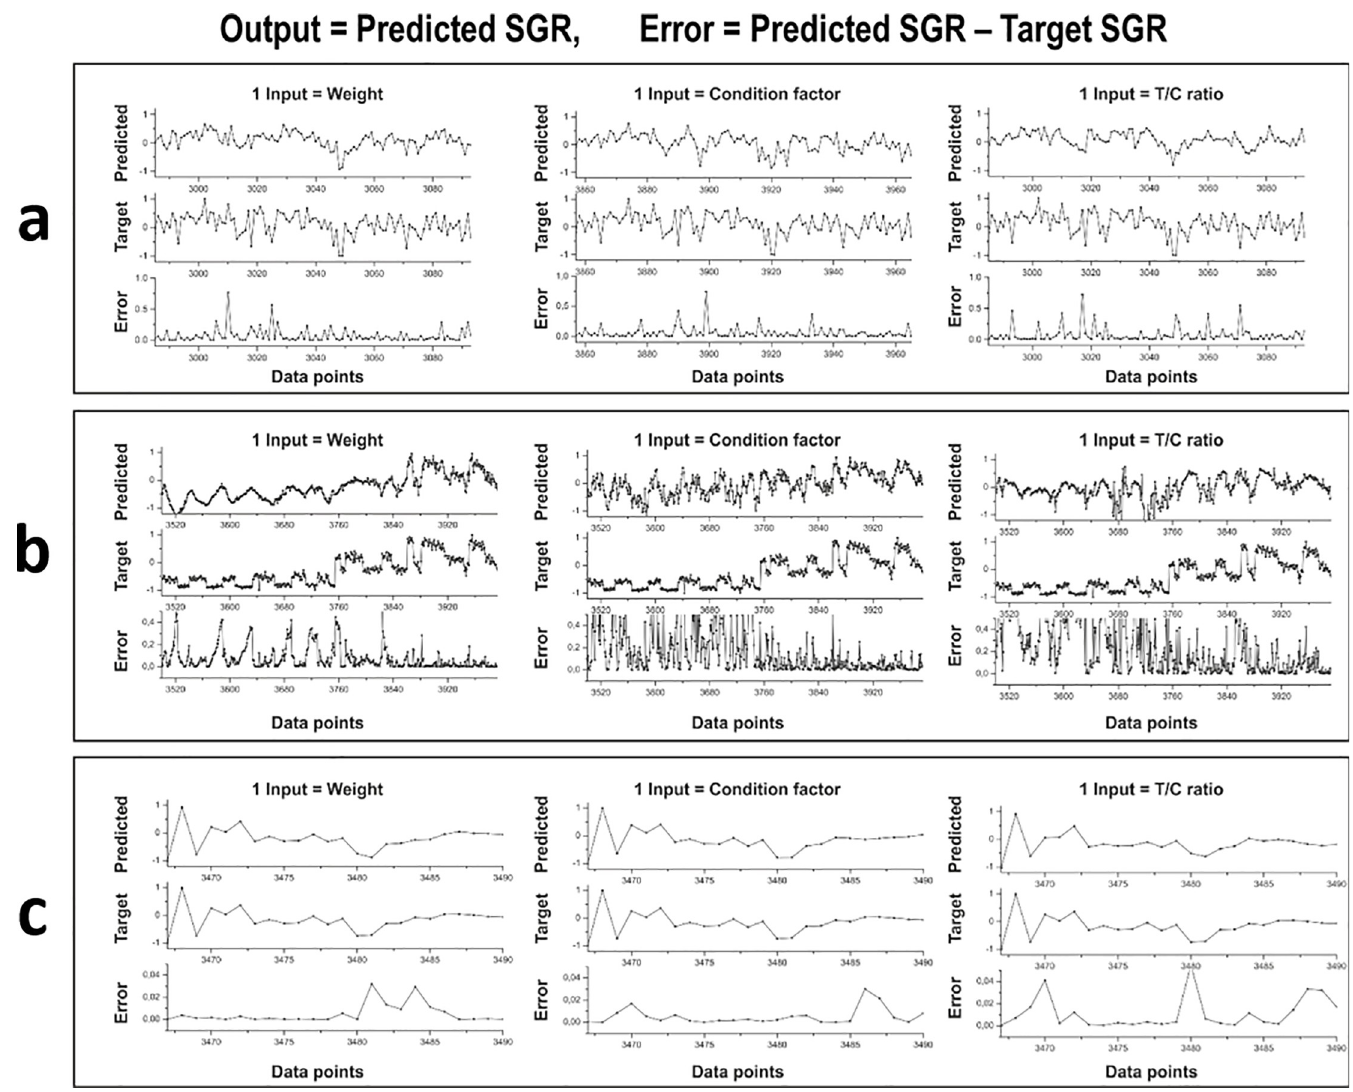
Fig 7. Comparison of predicted specific growth rate (SGR) outputs with the target normalized SGR using different single inputs. Different single inputs (weight, condition factor, or T/C ratio) into the reservoir-based neural network of our computational model were investigated, using a reservoir network size of 50 hidden neurons. (a) Data4: Rainbow trout at adult stage during maturation (Fig 1D). (b) Data1: Atlantic salmon at juvenile stage (Fig 1A). (c) Data2: Atlantic salmon at post- smolt stage (Fig 1B). Single inputs are not suitable because of a large number of errors in SGR estimation. The mean square errors using single inputs are shown in Table 2. Table 2). A preliminary study of Data4, using a large reservoir network size of 200 hidden neu- rons, indicated precise SGR estimations from the three-input combination with the lowest average error of 0.00047 (almost no error), compared to two-input combinations with an aver- age error range of 0.0038–0.0078 (Fig 6A). The studies on Data4 (Fig 6B), Data1 (Fig 6C), and Data2 (Fig 6D), using 50 hidden neurons, showed acceptable predicted SGR values from the three-input combination with an average error range of 0.0004–0.0436 (see Table 2). The use of 50 hidden neurons can reduce the computational time and cost, compared to 200 hidden neurons. Therefore, all trained models for SGR estimation were used with a reservoir network size of 50 hidden neurons and the three-input combination of normalized weight, normalized T/C ratio, and normalized CF.